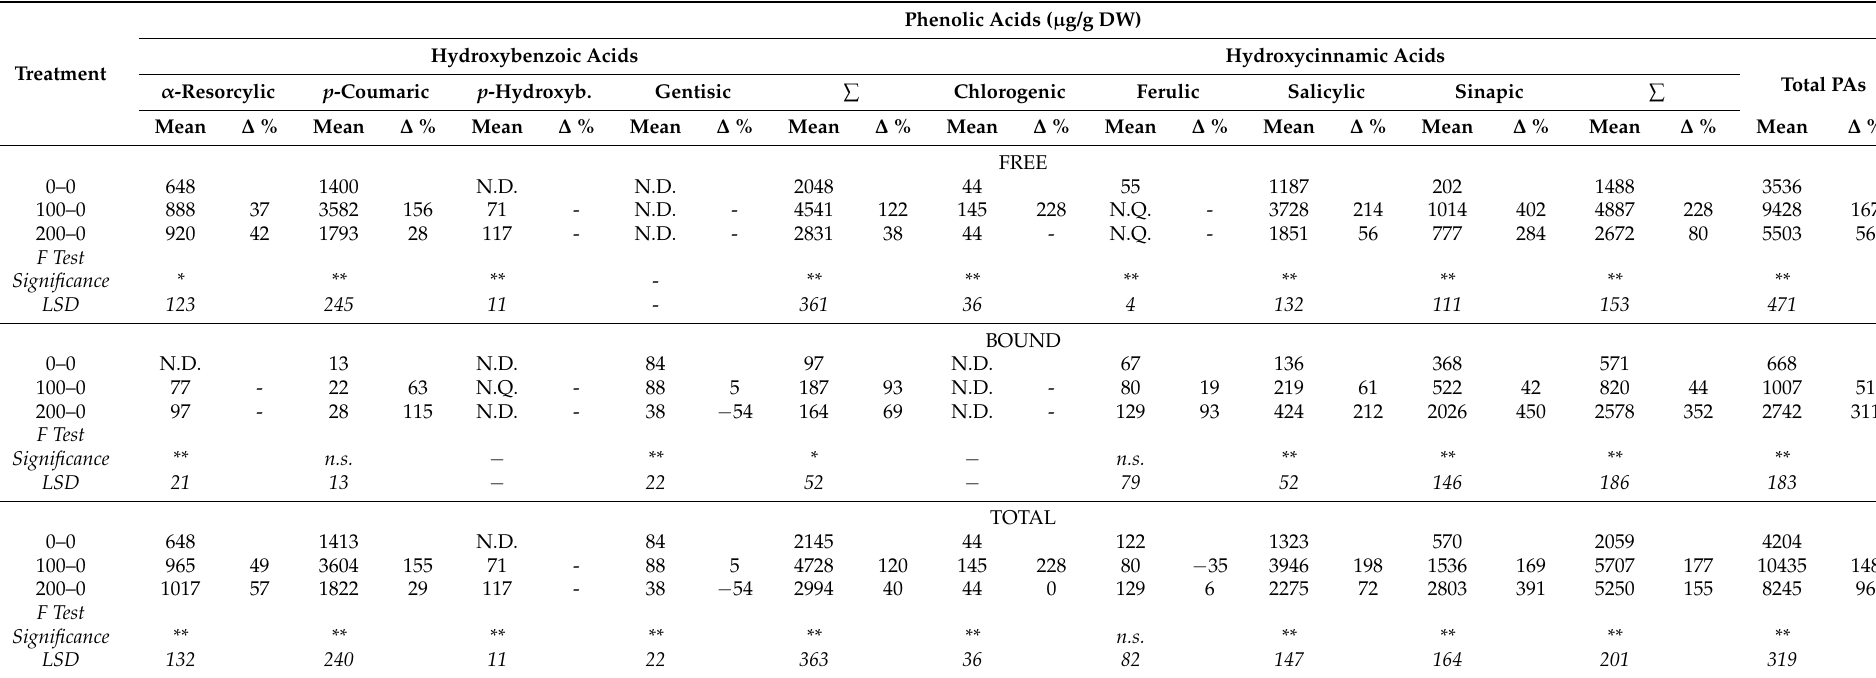
Table 5. Concentration ( µ g g − 1 DW) of the free, bound and total fractions of phenolic acids (PAs), regrouped as hydroxybenzoic and hydroxycinnamic acids, in the rapeseed sprouts obtained from seeds harvested from mother plants grown under the three salinity treatments S0, S100 and S200 (i.e., 0, 100 and 200 mM of NaCl in the solution used for watering the pots throughout the whole growing cycle). ∆ is the percent variation of treatments S100 and S200 as compared to S0. N.D.: not detected; N.Q.: not